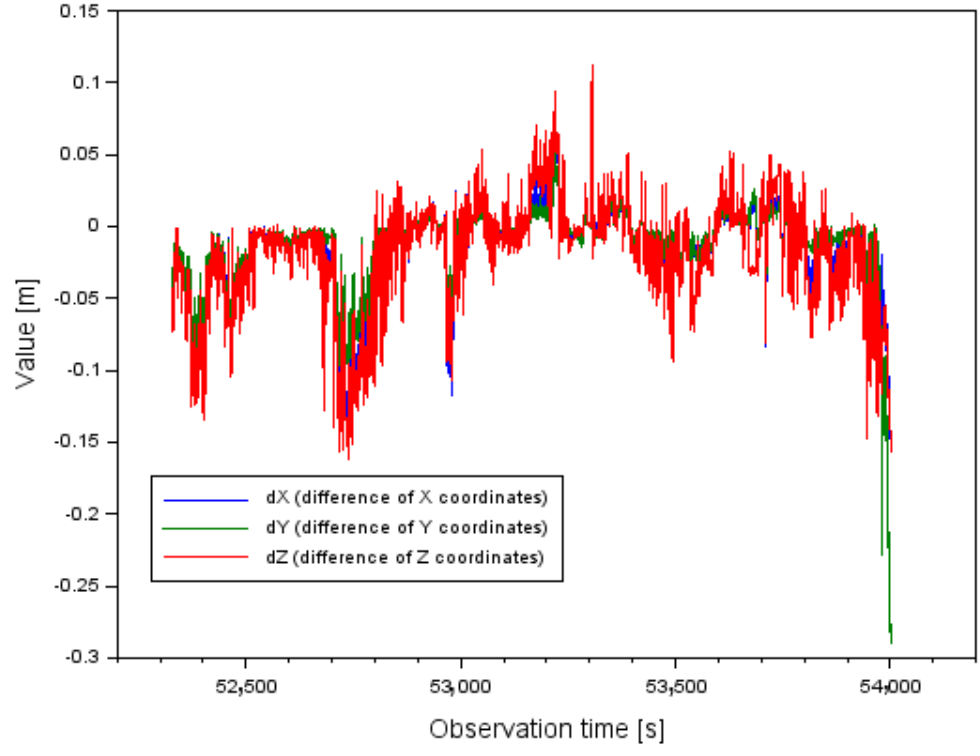
Figure 7. Difference of obtained XYZ coordinates of Cessna 172 aircraft.